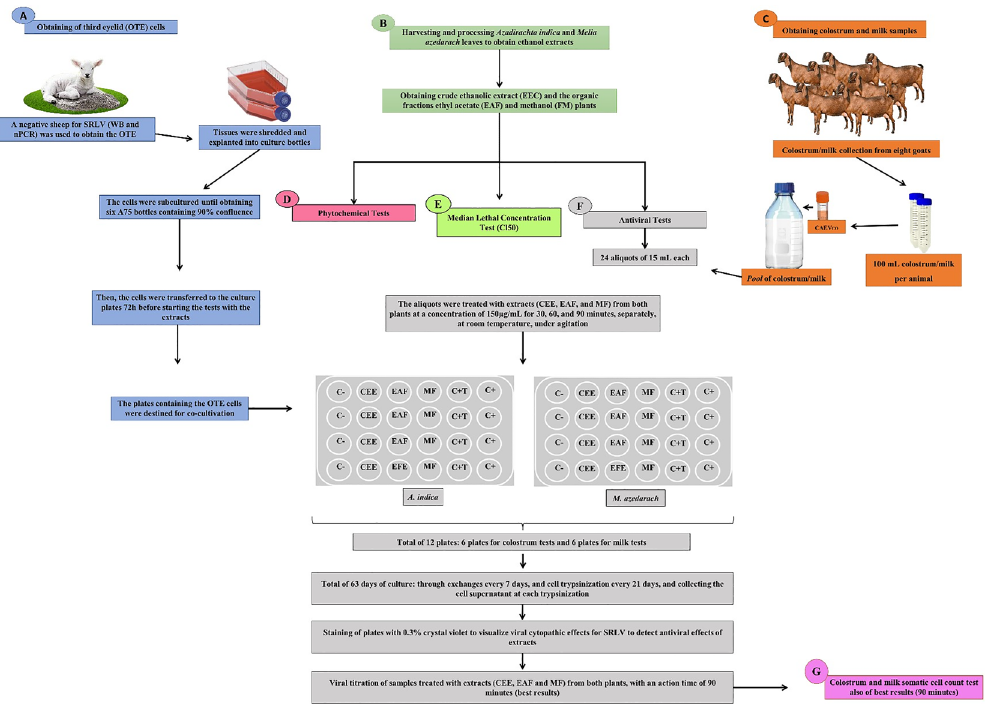
Figure 8. Illustration of the experimental design adopted in the evaluation antiviral in vitro activity ethanolic extracts of Azadirachta indica and Melia azedarach against the caprine lentivirus in colostrum and milk. OTE: ovine third eyelid; SRLV: Small Ruminant Lentiviruses; WB: Western Blot; n PCR: nested-Polymerase Chain Reaction; CAEV CO : standard viral strain; C-: Negative Control; C + T: Positive Control of Treatments; C+: Positive